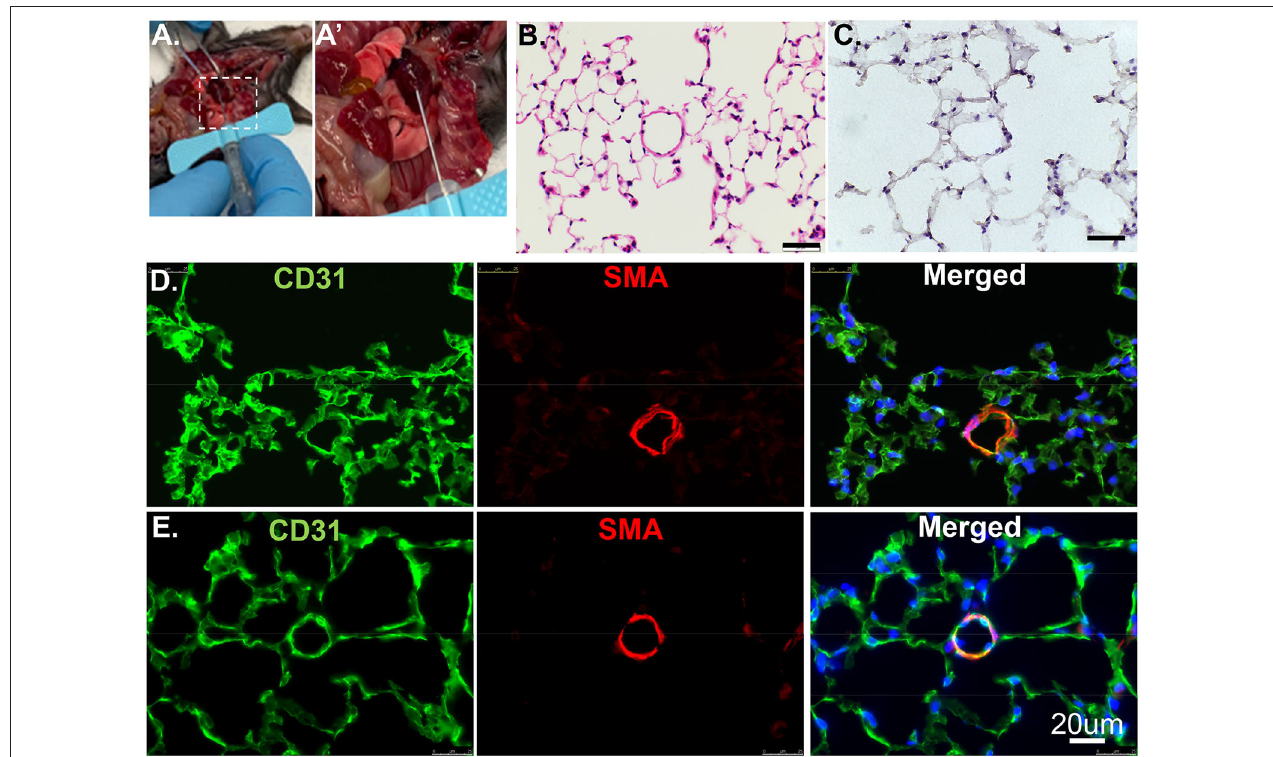
FIGURE 1 | Cross section of lung tissues using H&E or IF. (A) The RV is cannulated with a 25G butterfly needle to facilitate switching solutions from flushing buffer to PLP for pulmonary vascular perfusion. (A ′ ) Enlarged image of dashed rectangle in A . (B) Wildtype murine lung structure using H&E. Scale bar: 20 um. (C) Wildtype murine lung structure using H&E after inflation with 100% OCT. Scale bar: 20 um. (D) The same procedure as in C but applied IF staining. CD31: green, stained for endothelial; SMA: red, stained for smooth muscle layer; DAPI: blue, stained for nuclei. (E) PLP buffered murine lung described in manuscript providing improved structural integrity.